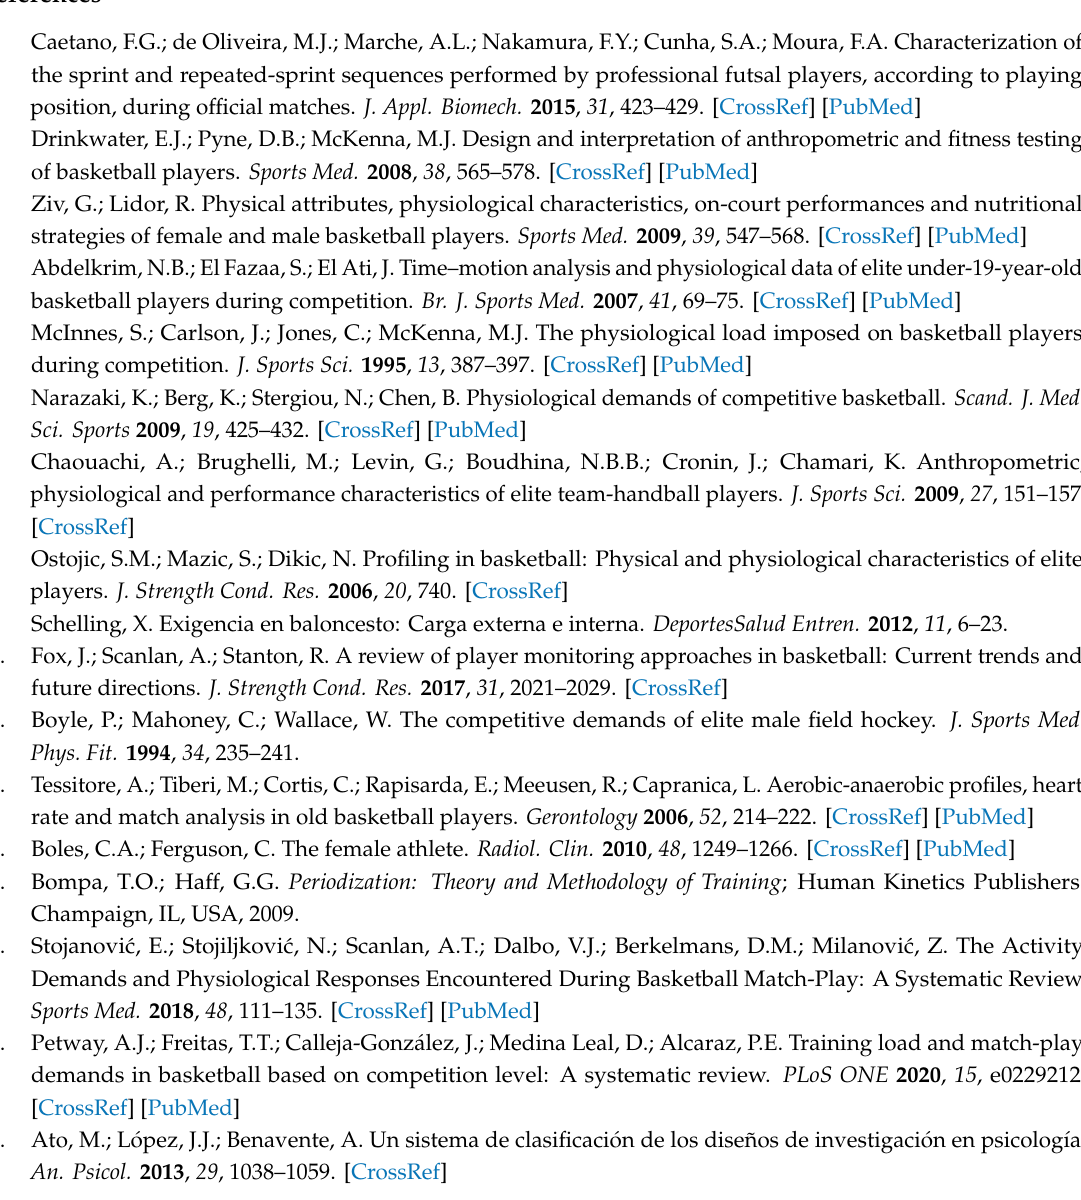
Table S1: Summary of